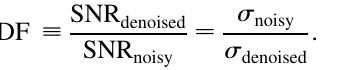
). The red lines ppg